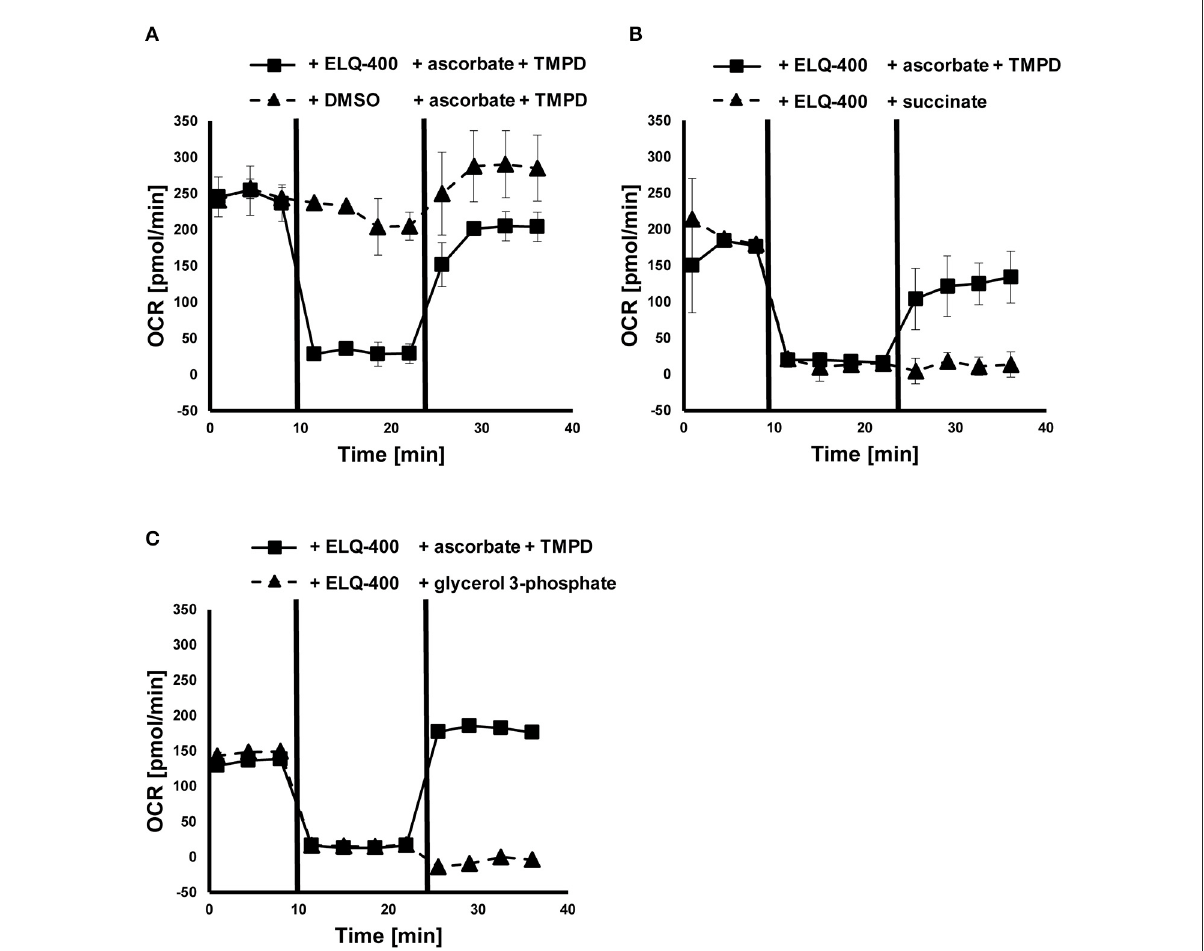
FIGURE4 Effects of ELQ-400 on the mitochondrial respiration of E. multilocularis germinal layer (GL) cells. The oxygen consumption rate (OCR) of E. multilocularis GL cells was measured by Seahorse XFp Extracellular Flux Analyzer. Succinate was given as an initial electron donor. After addition of 1 µ M ELQ-400 (but not DMSO), the OCR dropped, but recovered after addition of 20mM ascorbate and 0.6mM TMPD, which donate electrons to the mitochondrial respiration chain complex IV, thus downstream of the bc 1 complex (A) . OCR dropped after ELQ-400 treatment, but did not recover upon addition of 10mM succinate (B) , nor 10mM glycerol-3-phosphate (G3P, C ), both electron-donors which donate electrons upstream of the bc 1 complex. The experiment was repeated two times independently, and one representative plot is shown. Measurements were performed in triplicates, and mean values with standard deviations are shown.